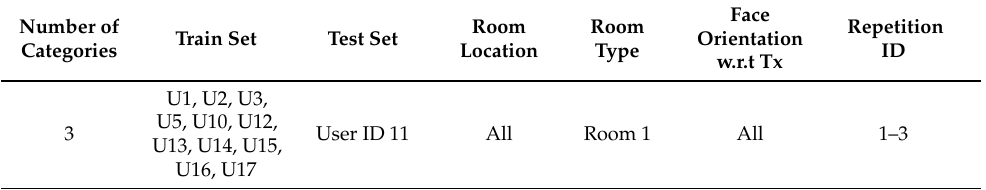
Table 2. Widar3.0 dataset, discussed in Section